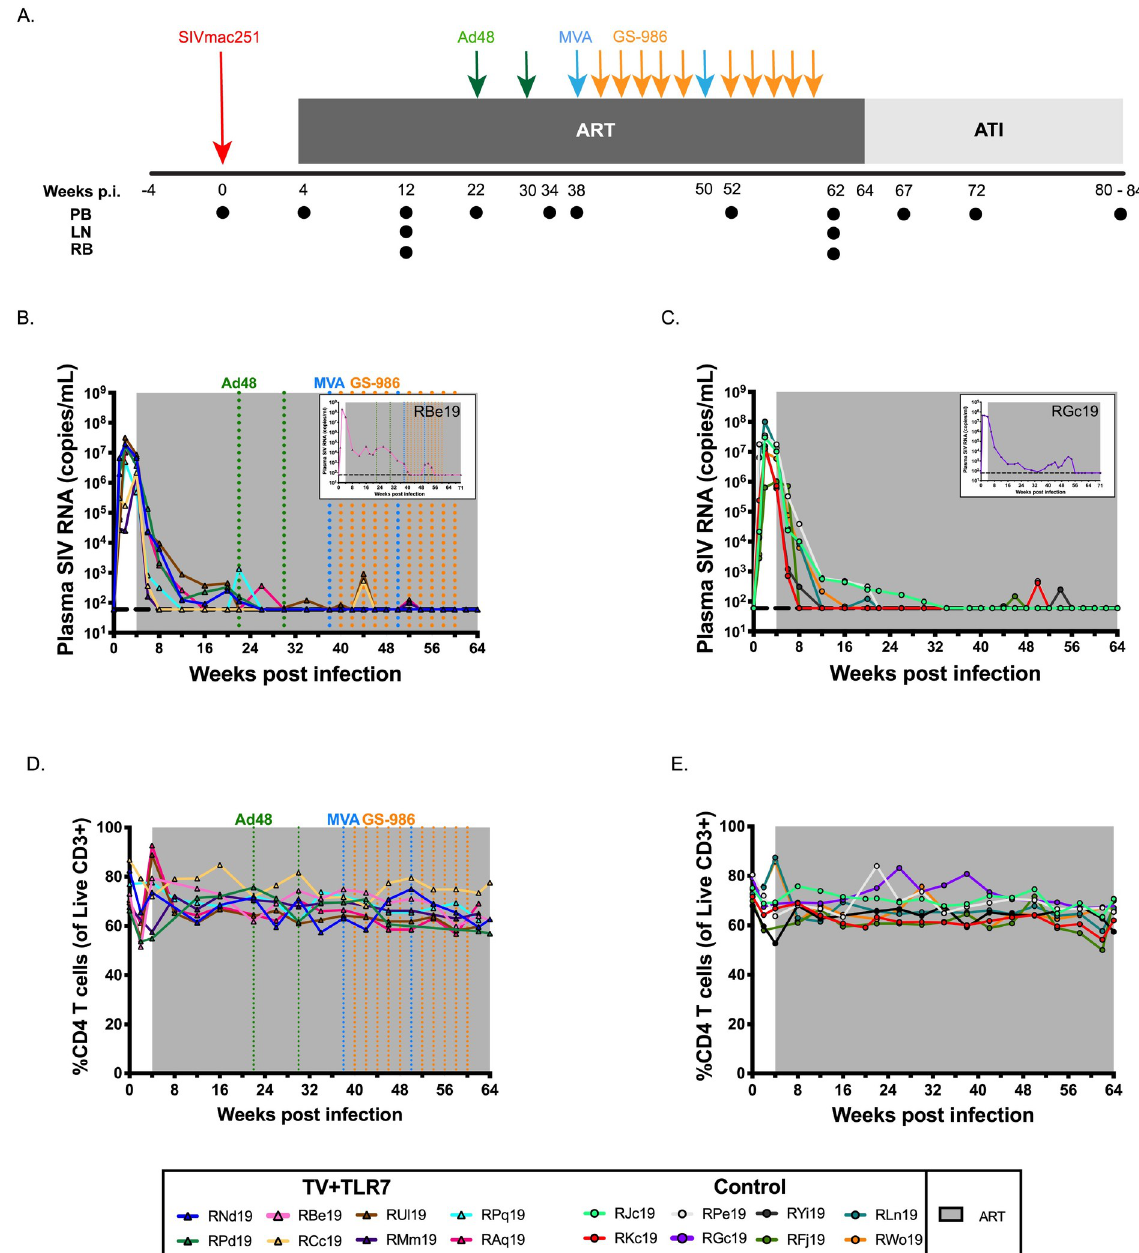
Fig 1. Experimental design and response to ART in SIV-infected infant RMs. (A) Schematic of the study design. Sixteen infant RMs were infected orally with 10 5 TCID 50 SIV mac251 (day 0), and starting on 4 weeks post infection (p.i.) treated with combination ART (TDF, FTC, DTG) for 15 months. Eight animals received 2 doses of Ad48-SIV smE543 gag-pol-env (3x10 10 viral particles, i.m.), 2 doses of MVA-SIV smE543 gag-pol-env (1x10 8 PFU, i.m.), and 10 doses of GS-986 (0.3 mg/kg, o.g.), at the timepoints indicated (TV+TLR7). The remaining 8 animals served as ART-treated controls. At 64–71 weeks p.i. RMs underwent analytical treatment interruption (ATI) and all the animals were monitored for 4 to 6 months. PB, RB, and LN biopsies were collected at the indicated timepoints. Longitudinal analysis of plasma SIV RNA levels in (B) TV+TLR7 and (C) control RMs. The shaded area represents the period of ART treatment. The dashed line represents the limit of detection of the assay. Longitudinal analysis of peripheral CD4 + T cell frequency in (D) TV+TLR7 and (E) control RMs. The shaded area represents the period of ART treatment.